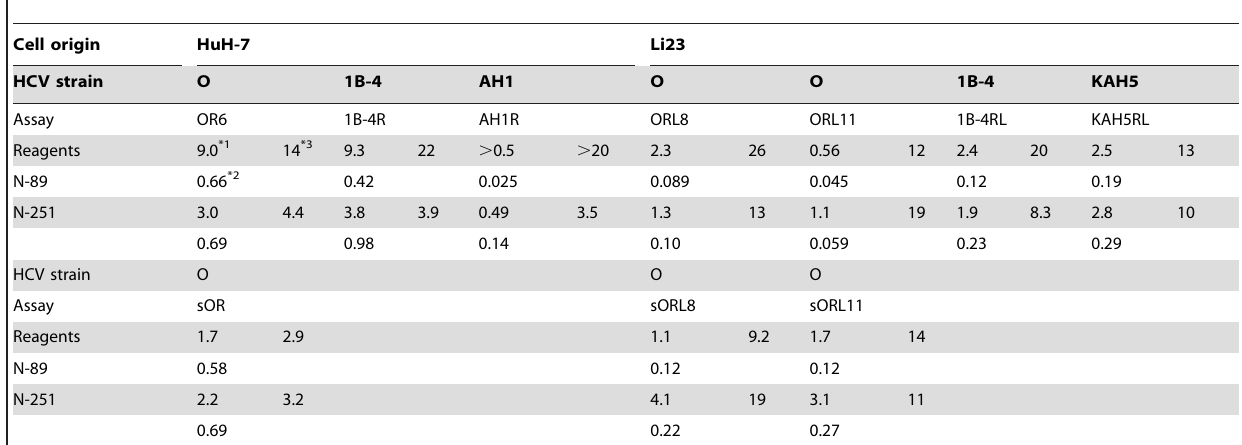
Table 1. Anti-HCV activities of N-89 or N-251 in various HCV drug assay systems.